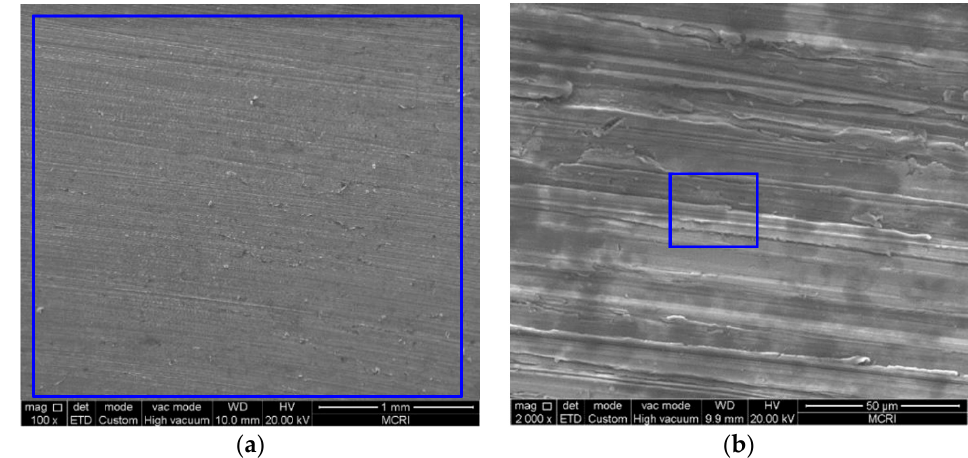
Figure 5. SEM images of corrosion scales formed on the steel surface in 30% crude oil/brine mixtures at Pco 2 = 0 MPa: ( a ) ×100; ( b ) ×2000.